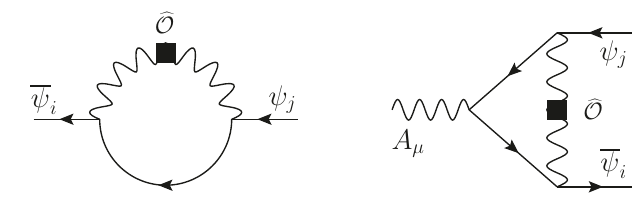
Figure 1 . Diagrams with b O ≡ d S AA